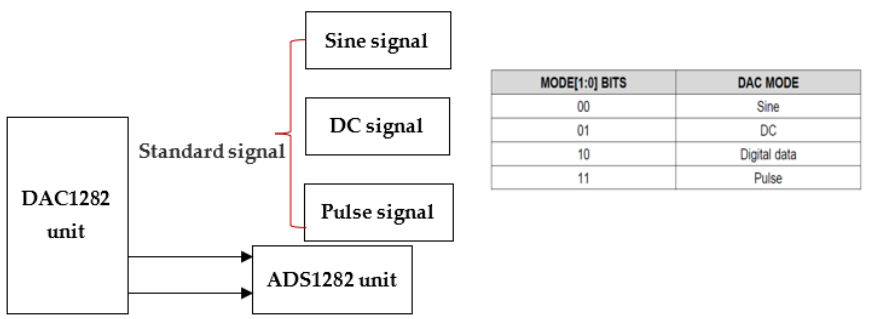
Figure 16. Structural diagram of the receiver calibration module.